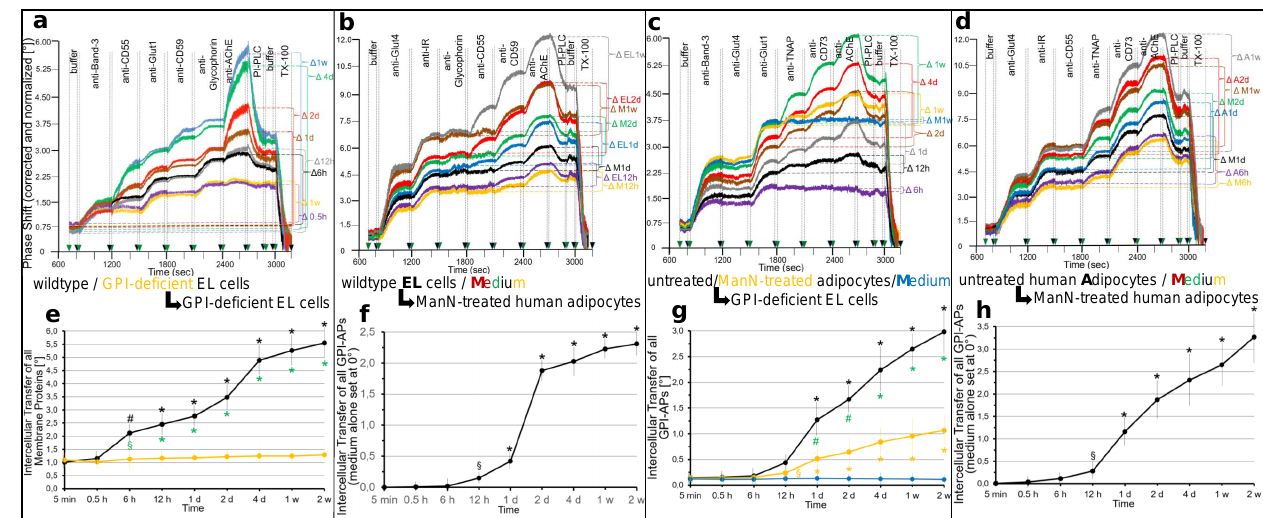
Figure 8. Transfer of full-length GPI-APs from donor to acceptor cells in transwell co-culture. Transwell co-cultures were run with donor and acceptor cells in the insert and bottom wells, re- spectively, as described in Materials and Methods in homologous configuration (( a , e ), GPI-deficient [orange curves] or wildtype [other colors] EL cells and GPI-deficient EL cells; ( d , h ), untreated human adipocytes of lipid-loading stage II [A] or medium alone [M] and ManN-treated human adipocytes of lipid-loading stage II) or heterologous configuration (( b , f ), wildtype EL cells [EL] or medium alone [M] and ManN-treated human adipocytes of lipid-loading stage II; ( c , g ), ManN-treated [orange curves] or untreated [other colors] human adipocytes of lipid-loading stage II or medium alone [blue curve]). After incubation (37 ◦ C) for various times (h, hours; d, days; and w, weeks), PM were prepared from the cells of the bottom wells, coupled to chips by ionic/covalent capture and then analyzed for expression of the membrane proteins indicated by SAW sensing as described for Figure 1. ( a – d ) Phase shifts induced by binding of antibodies against GPI-APs or transmembrane proteins and by PI-PLC- and TX-100-treatment (from 700 to 3100 s) are shown, only, omitting the preceding capturing procedures (0–700 s, see Figure 1). Correction and normalization of the phase shift were performed as described in the legend to Figure 1. Phase shift ∆ between injection of the first (at 800 s) and last (at 2700 s) antibodies against membrane proteins ( a ) as well as of the first (at 1800 s ( b , c ); 1500 s ( d )) and last (2700 s ( b – d )) antibodies against GPI-APs are indicated by horizontal hatched lines and brackets for each period ([A] donor adipocytes, [EL] donor EL cells, [M] medium alone in the inset wells). ( e – h ) The experiments were repeated three to six times for the indicated configurations and periods. Phase shift ∆ induced by antibodies against all membrane proteins ( e ) or only against all GPI-APs ( f – h ) were used for calculation of the homologous ( e , h ) or heterologous ( f , g ) intercellular transfer. ( f , h ), Phase shift ∆ for each incubation of acceptor with donor cells was corrected for that with medium alone in the insert wells (“M” in ( b , d )). ( e – h ) Significant differences vs. 5-min incubation are indicated (black and orange symbols). Significant differences between wildtype and GPI-deficient EL cells ( e ) or untreated and ManN-treated human adipocytes ( g ) as donor cells are indicated (green symbols) (* p ≤ 0.01, # p ≤ 0.02, § p ≤